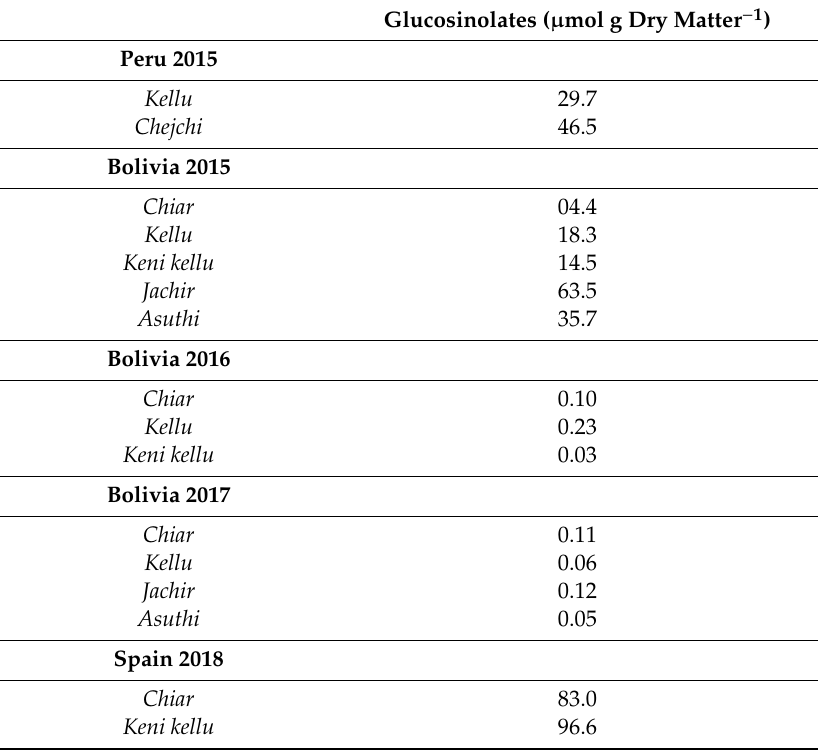
Table 6. Variations in glucosinolate (desulfoglucoaubrietin) content in mashua tubers collected in Peru and Bolivia from 2015 to 2017. Included, control values from tubers harvested in Spain.